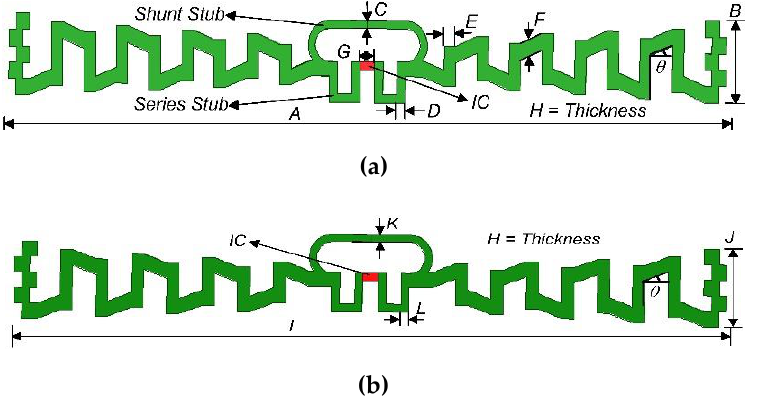
Figure 4. ( a ) Conductive Asahi paste I-RFID Tag for European UHF RFID standard and ( b ) conductive Asahi paste I-RFID Tag for North American UHF RFID standard.